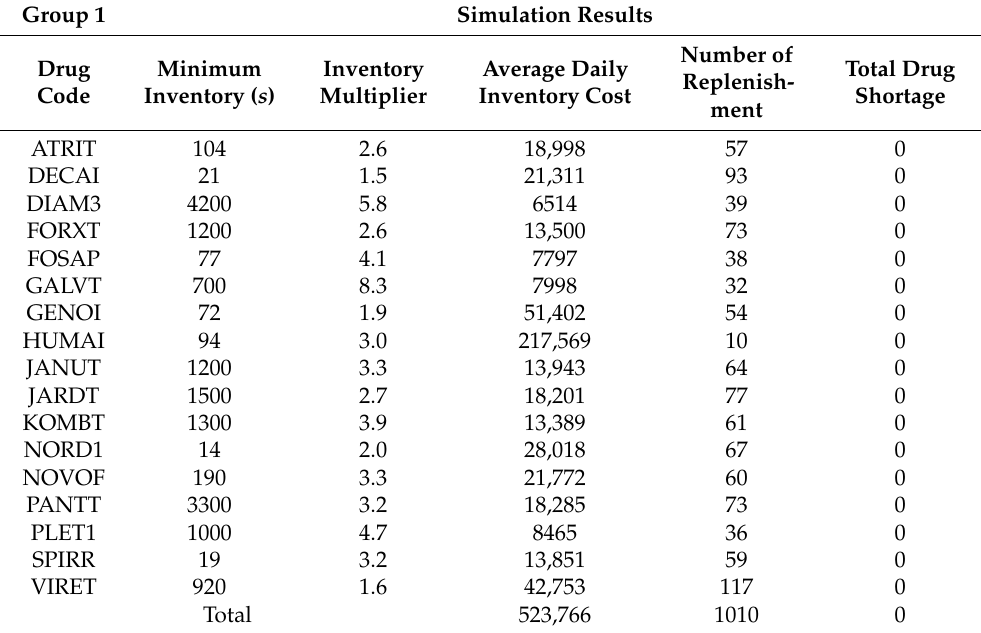
Table 3. Results for 17 drugs in Group 1 for Scenario 2.